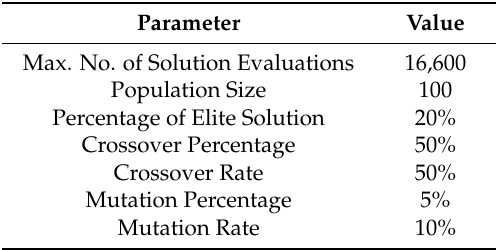
Table 6. The optimization parameters used for all